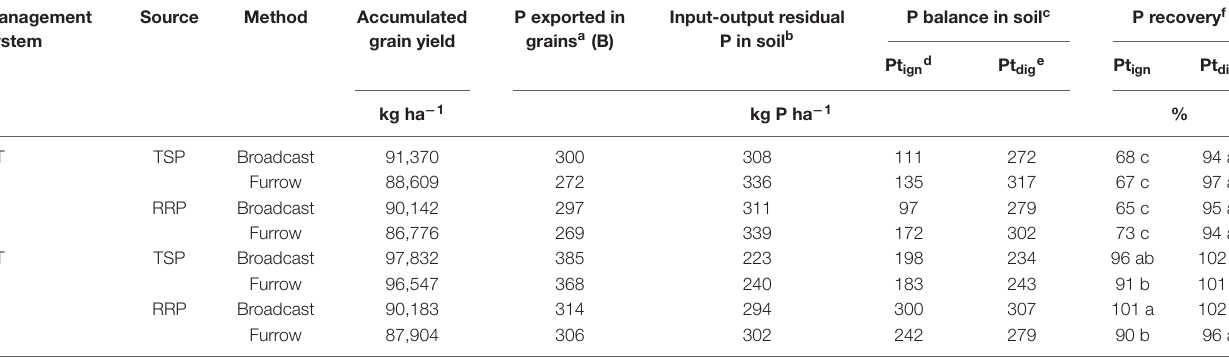
TABLE 2 | Soil P balance in a clayey Oxisol cultivated for 17 years under distinct soil management systems, phosphate fertilization sources, and application methods. Management